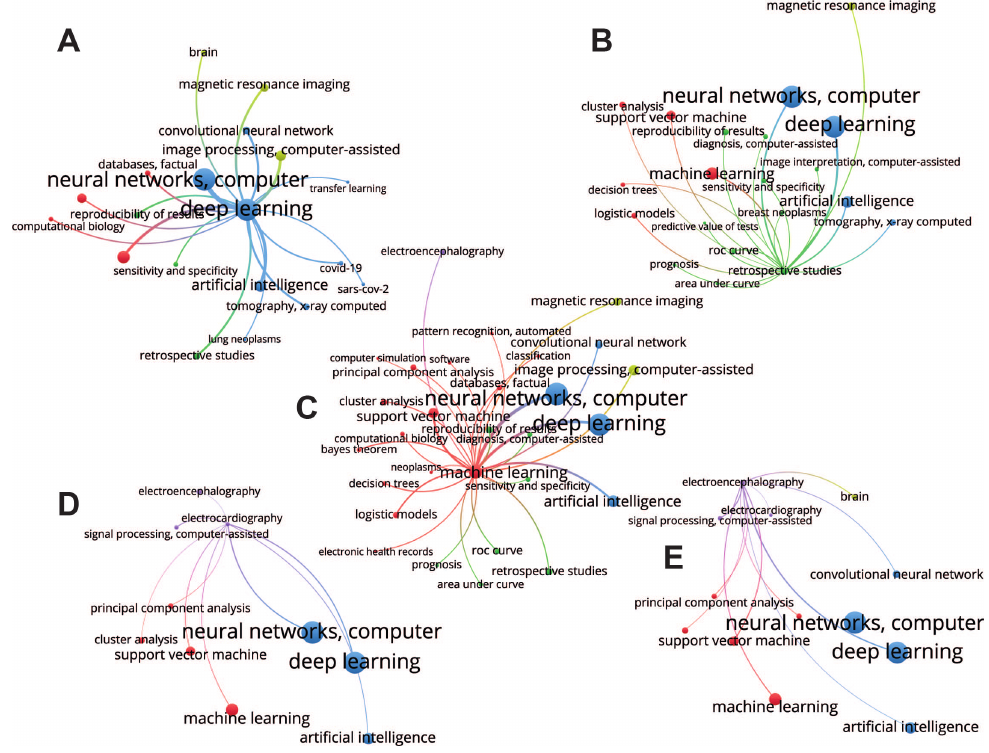
Figure 4. Selected subnetworks of interest with the largest nodes corresponding to deep learning ( A ), retrospective studies ( B ), machine learning ( C ), electrcardiography ( D ) and electroencephalography ( E